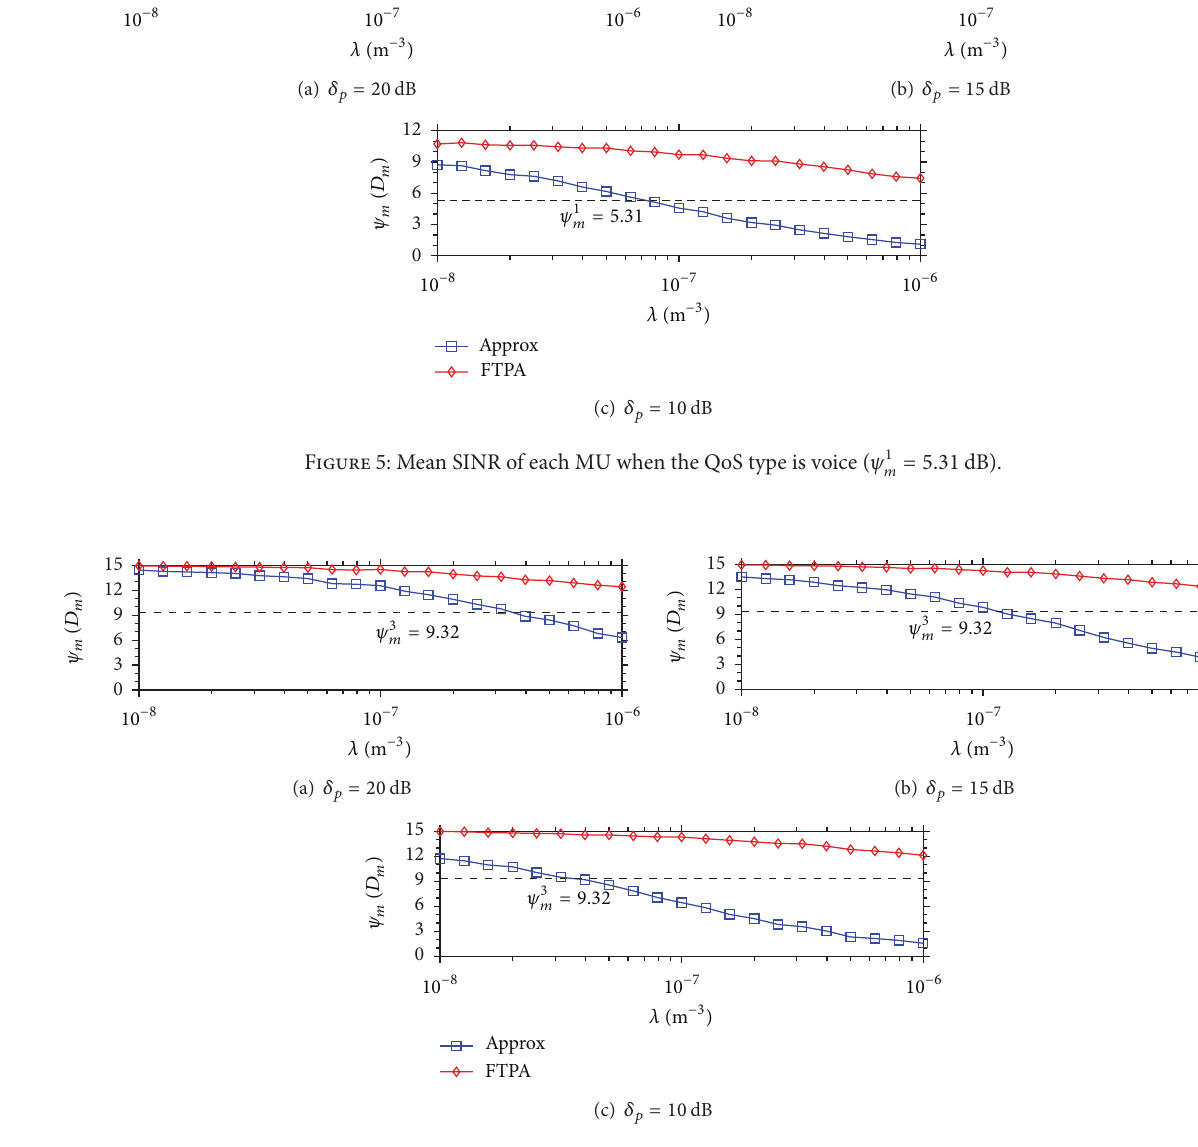
Figure 6: Mean SINR of each MU when the QoS type is CBR video ( 𝜓 3 𝑚 = 9.32 dB).